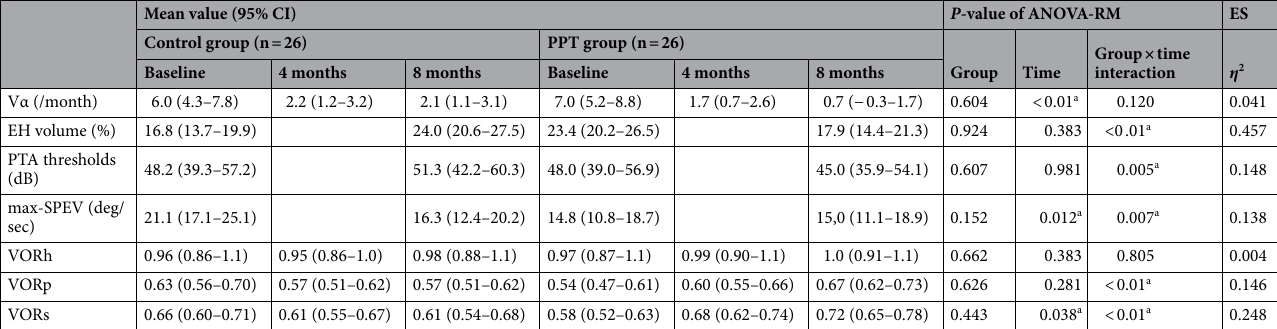
Table 2. Changes in and comparison of outcome constructs between the control and PPT groups. ANOVA-RM two-factor repeated measures analysis of variance, CI confidence interval, ES , effect size, Vα number of attacks of vertigo per month, EH endolymphatic hydrops, PTA pure-tone audiometry, max-SPEV maximum slow phase velocity, VORh the value of horizontal vestibulo-ocular reflex (VOR) gain, VORp the value of posterior VOR gain, VORs the value of superior VOR gain. a Statistically significant